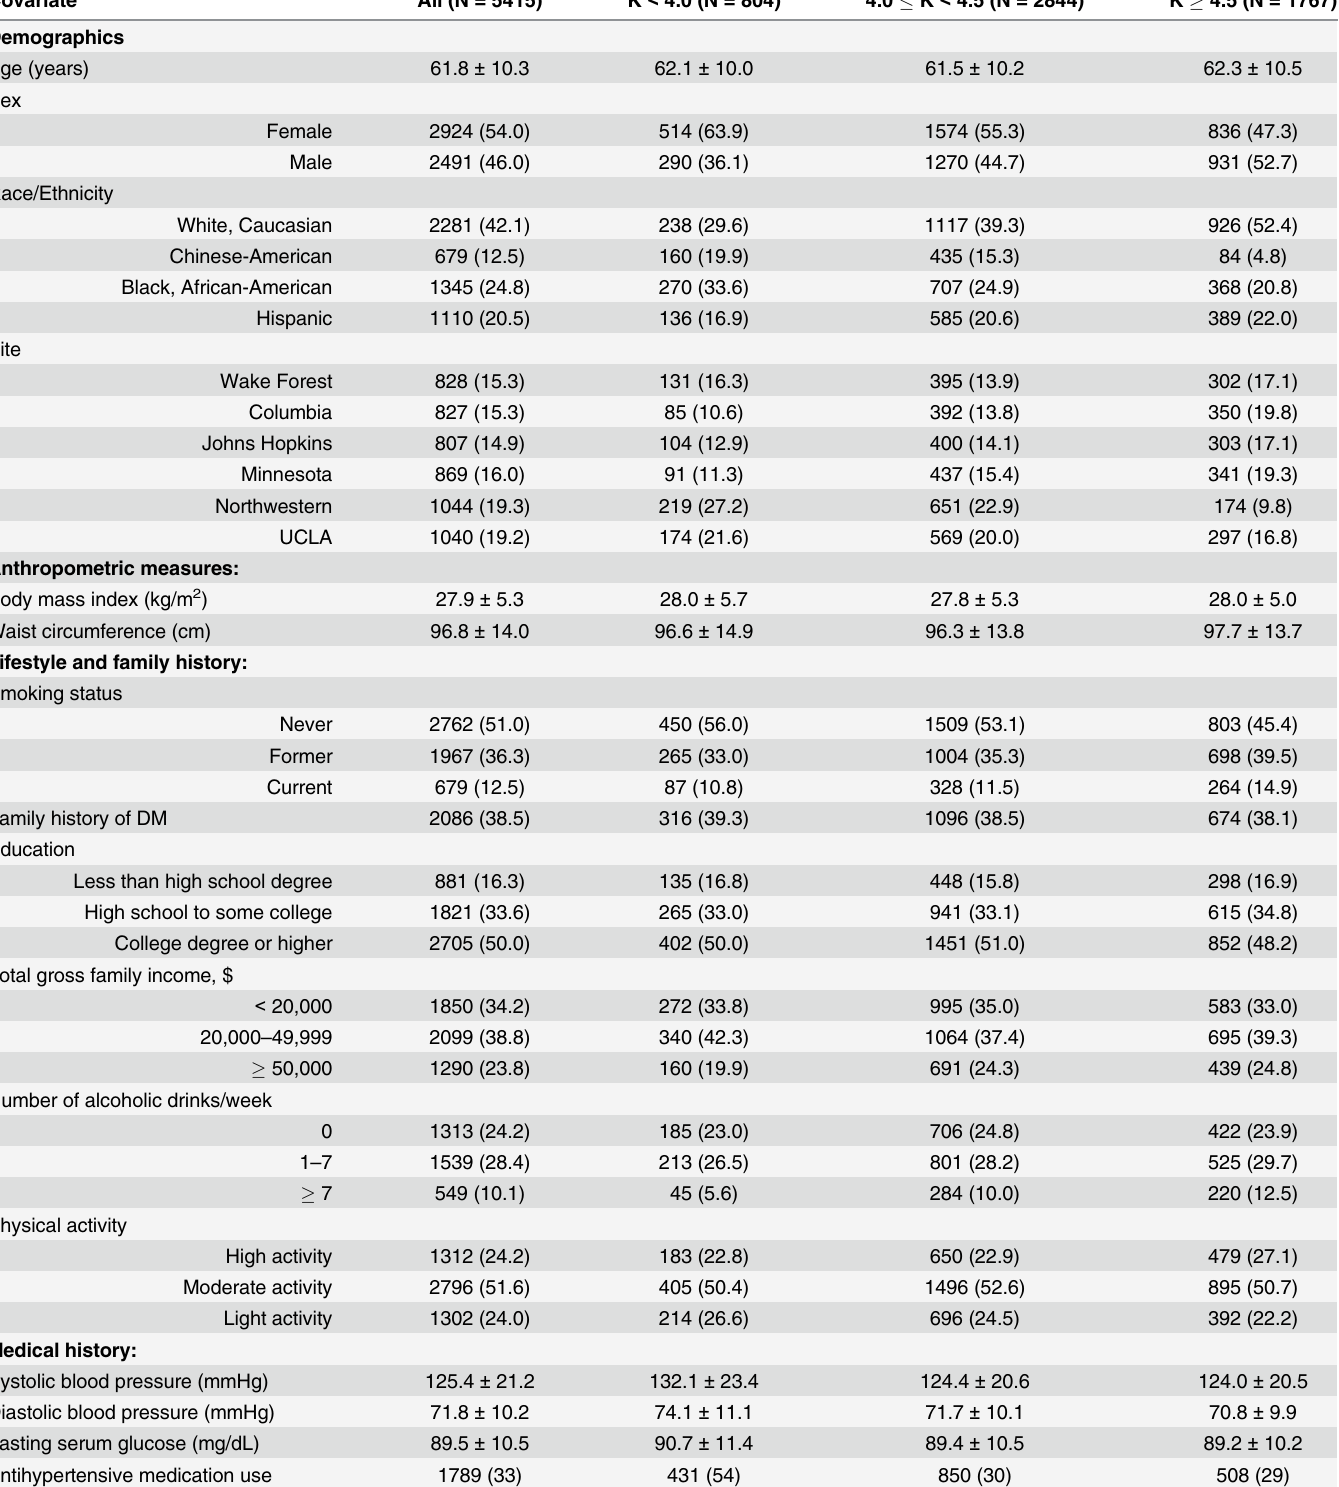
Table 1. Baseline Characteristics of Study Population (N = 5415), by Serum K (mmol/L).